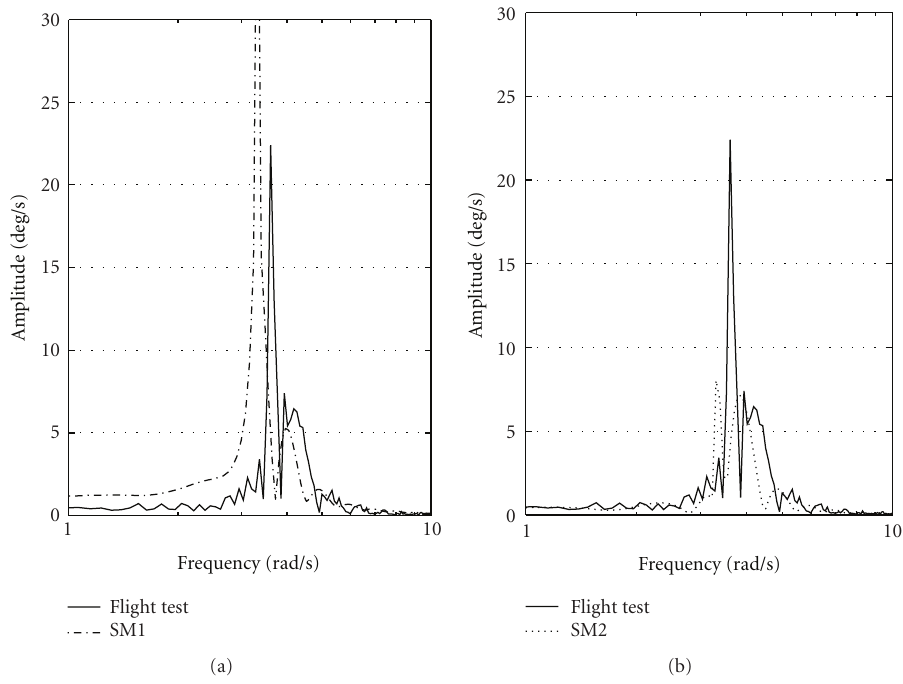
Figure 11: The e ff ect of model complexity on pitch rate spectral response (drogue parachute).